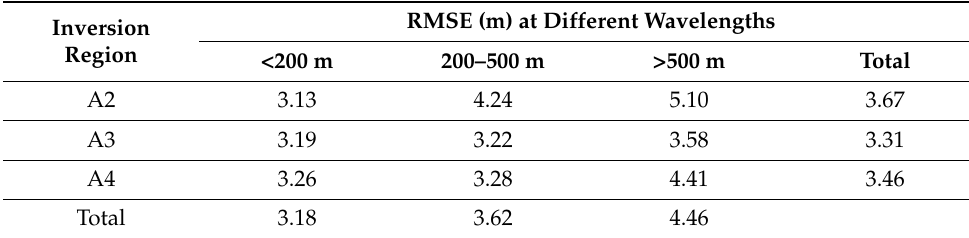
Table 4. Verification of the accuracy of sand wave depth at different wavelengths.